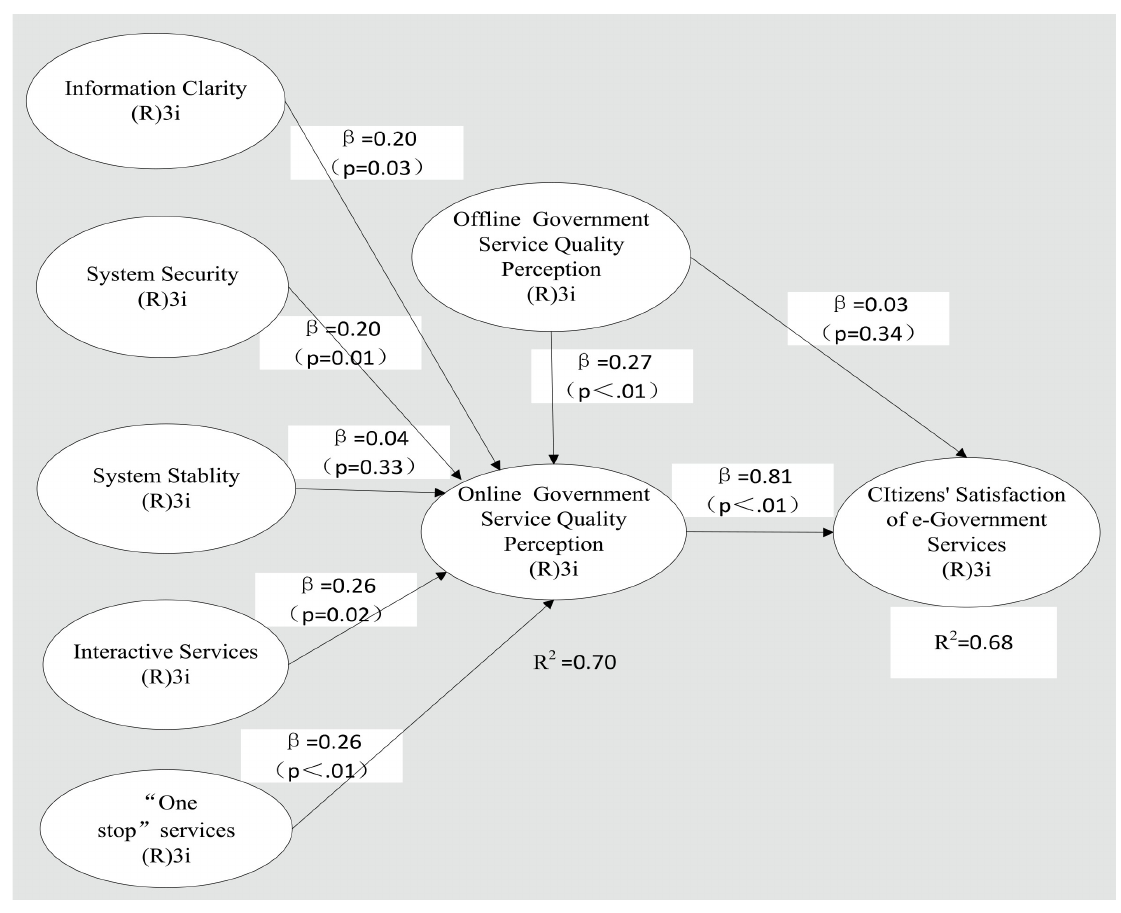
Figure 4. SEM analysis